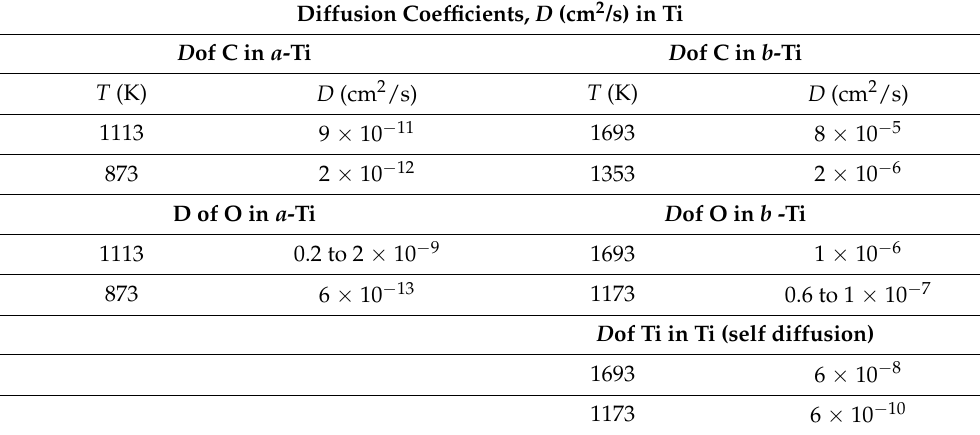
Table 1. Diffusion coefficients for carbon, oxygen, and titanium atoms in titanium. Data is from Nakajima and Koiwa (1991) [74]. Diffusion Coefficients, D (cm 2 /s) in Ti D of C in a -Ti D of C in b -Ti T (K) D (cm 2 /s) T (K) D (cm 2 /s) 1113 9 × 10 − 11 1693 8 × 10 − 5 873 2 × 10 − 12 1353 2 × 10 − 6 D of O in a -Ti D of O in b -Ti 1113 0.2 to 2 × 10 − 9 1693 873 1173 D of Ti in Ti (self diffusion) 1693 1173 6 × 10 −